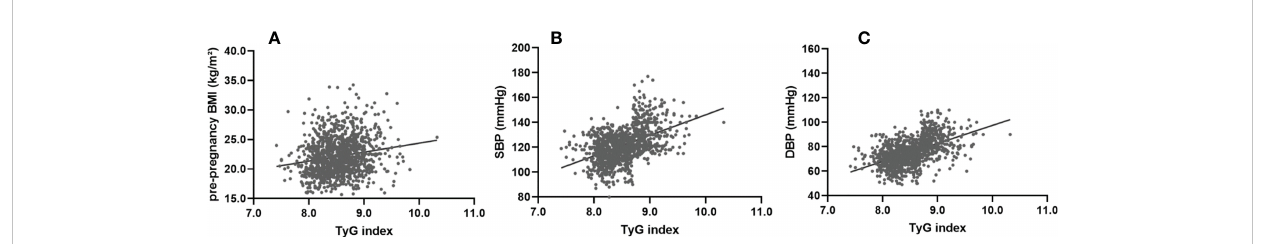
FIGURE 3 Simple linear regression analysis between the TyG index at fi rst visit and pre-pregnancy BMI, SBP and DBP one week before delivery. The TyG index showed a signi fi cant and moderate linear association with pre-pregnancy BMI ( b =0.31; F=65.21; adjusted R²=0.09; P<0.001) (A) , SBP ( b =0.25; F=41.48; adjusted R²=0.06; P<0.001) (B) , and DBP ( b =0.38; F=106.11; adjusted R²=0.14; P<0.001) (C) . SBP, systolic blood pressure; DBP, diastolic blood pressure.